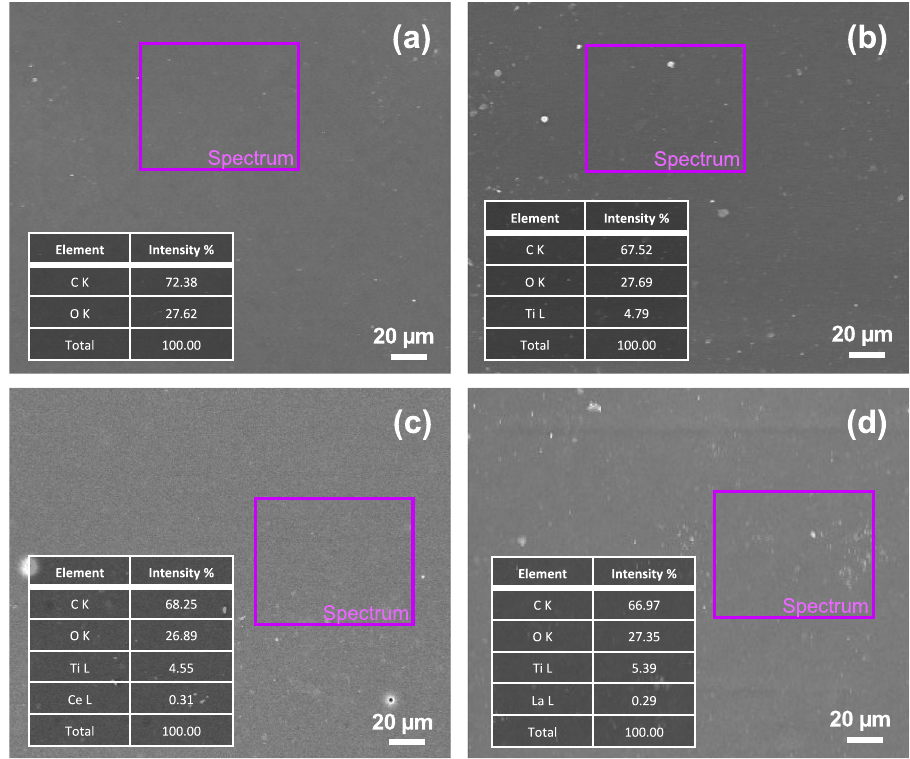
Fig. 2 SEM micrographs. a Pure_polyurea, with b undoped TiO 2 , c 3%Ce-doped TiO 2 , and d 3%La-doped TiO 2 polyurea coatings. After the introduction of undoped nano-TiO 2 and Ce/La-doped nano-TiO 2 into the polyurea coating sample, the coatings indicated micro-scale convex structures with 1.5 – 5.8 μ m of diameters randomly oriented and aggregated on their